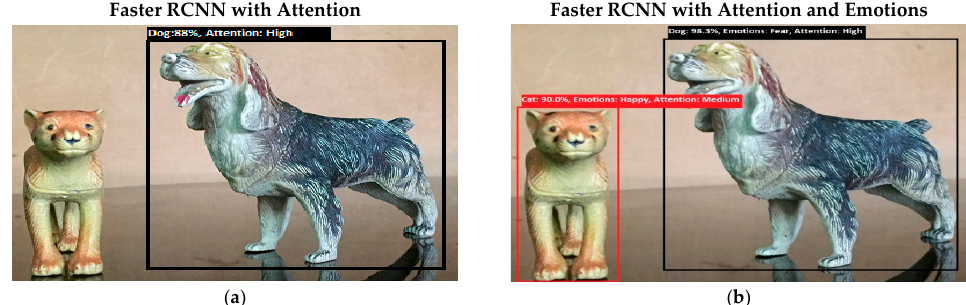
Figure 9. ( a ) The performance of the system against the query to “find Dog”. Attention is regulated towards the dog object under the influence of asked query. ( b ) The performance of the system against the query to “find Dog”. In this experimental PSA system, internal emotions shift towards fear from happy emotions. Attention is regulated towards the dog object under the influence of asked queries and emotions.